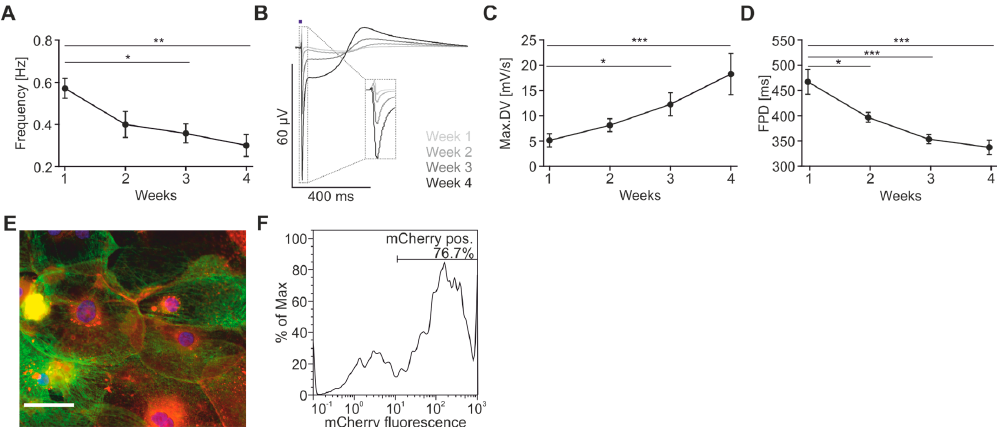
Figure 2. Analysis of field potential (FP) signals over four weeks after adeno-associated virus (AAV)-transduction and plating of human-induced pluripotent stem cell (hiPSC)-derived cardiomyocytes. ( A ) Spontaneous beat rate over time (from week 1 to week 4: − 47 ± 17%; p = 0.0077; n = 7); ( B ) overlay of representative FP optically paced at 1 Hz (blue bar); ( C ) analysis of maximum negative downstroke velocity (max.DV) (from week 1 to week 4: +256 ± 22%; p = 0.0005; n = 7) and ( D ) field potential duration (FPD) over time (from week 1 to week 4: − 28 ± 4%; p < 0.0001; n = 7); ( E ) microscope picture of Channelrhodopsin-2 (ChR2)-expressing Cor.4U ® cells taken at week 3 (blue = DAPI, green = Troponin T, red = mCherry from ChR2-mCherry fusion protein, scale bar: 50 μ m); ( F ) representative ( n = 3) fluorescence-activated cell sorting (FACS)-profile of ChR2-mCherry positive cells at week 3. * p < 0.05, ** p < 0.01, *** p < 0.001.